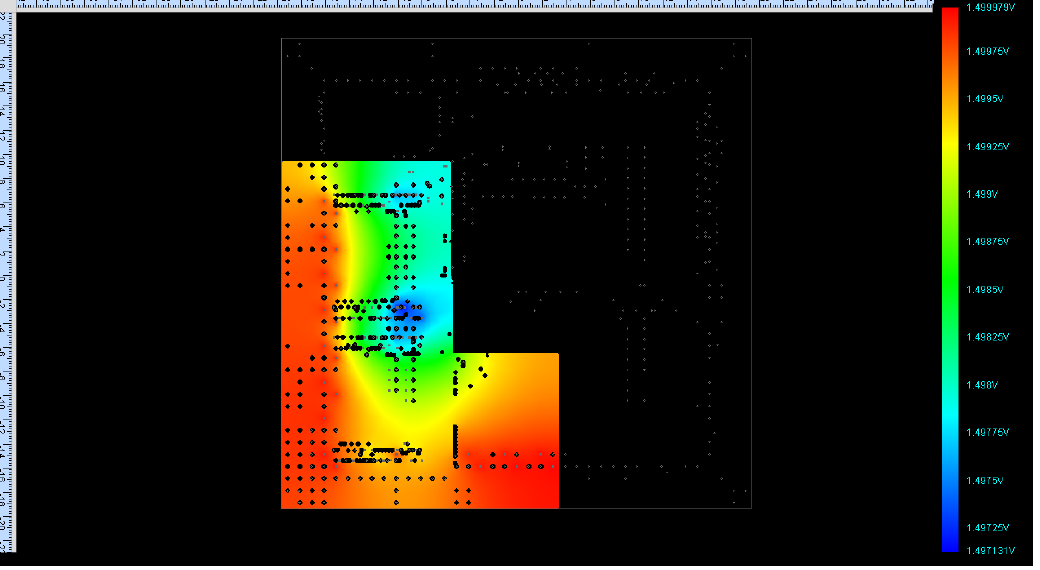
Figure 3. Voltage simulation result of the power supply DDR3 1.5 V is 1.49999~1.49737 V.